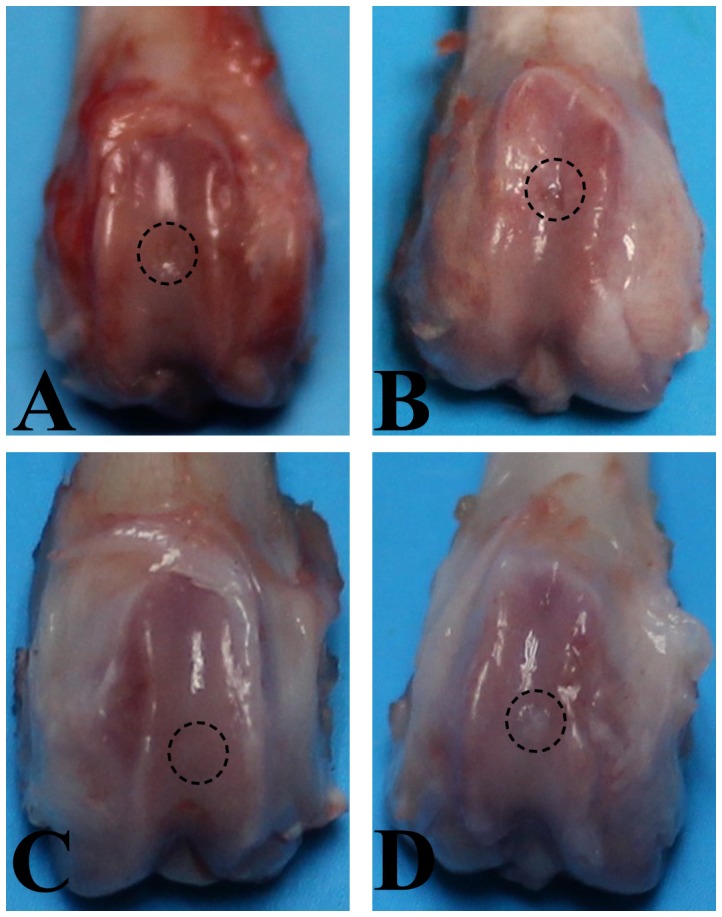
Macroscopic appearance of an operated knee at explantation after 14 weeks of follow-up.A. SED group. Defect is partially filled with repair tissue. B. 2W group. The margin of the normal cartilage around defect was eroded. C. 4W group. Defect is covered by smooth, glistening white tissue that was almost indistinguishable from the surrounding normal cartilage. D. 8W group. Defect is filled with a white cartilage-like tissue with an irregular surface, and the boundary of the defect was obvious.